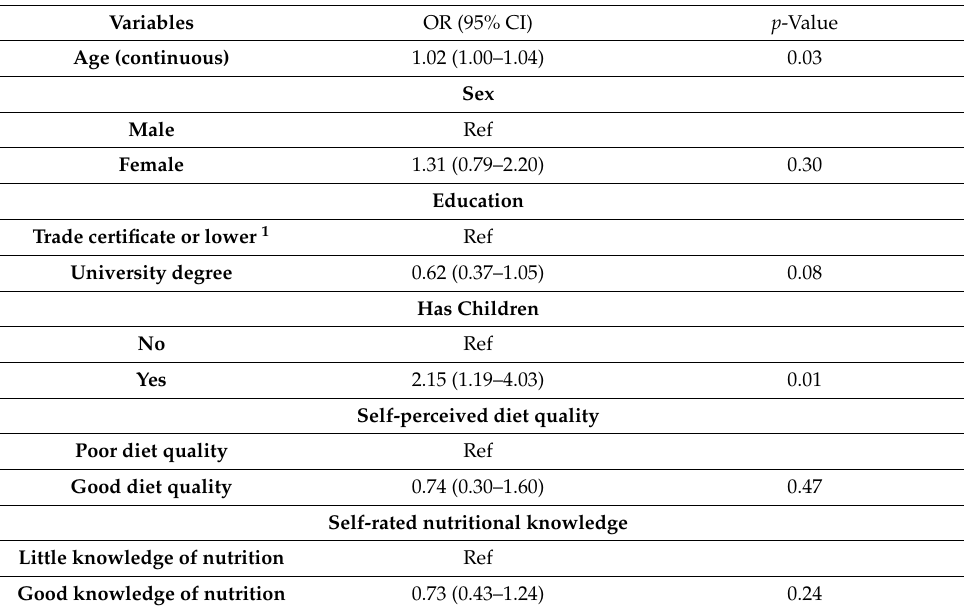
Table 2. Association between the variable “Nutri-Score helps me differentiate these added fats in terms of nutritional quality” (participants who did not agree as reference, N = 74) and socio- demographic characteristics using multi-adjusted logistic regression analyses (N = 462).